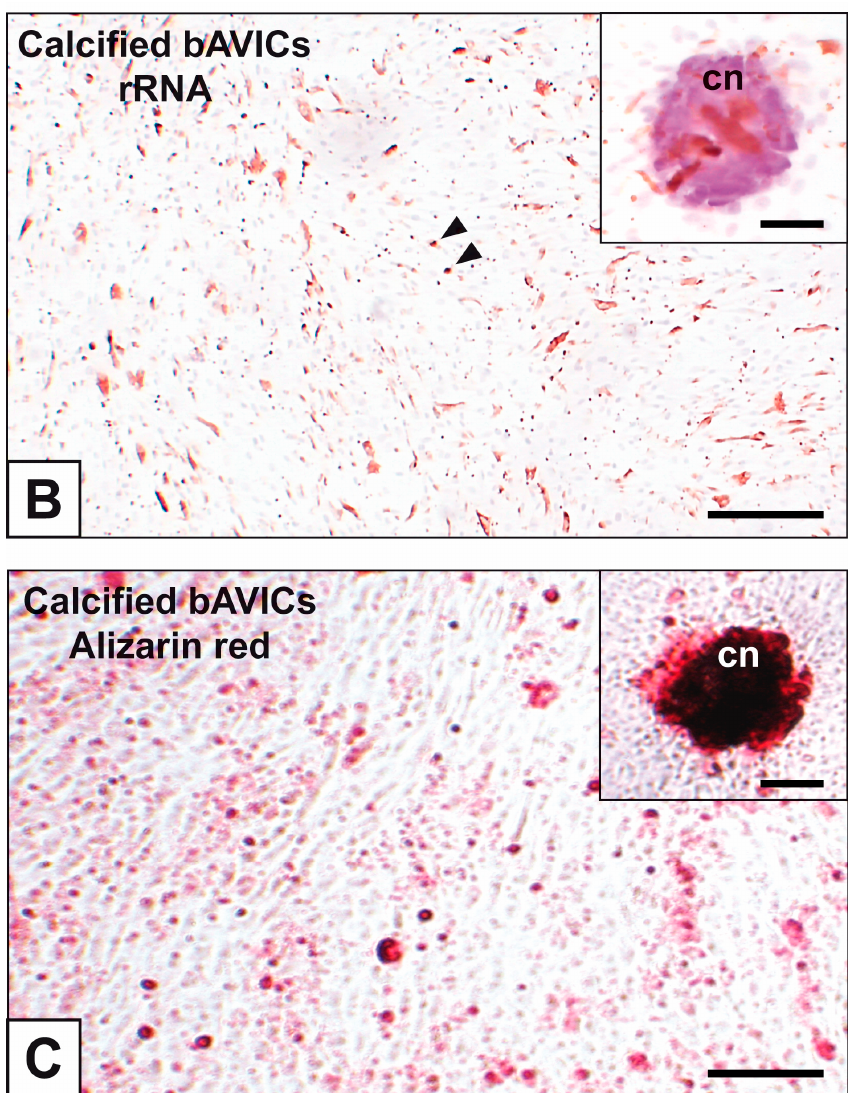
Figure 1. Immunocytochemical detection of rRNA in 15-day-long bovine aortic valve interstitial cell (bAVIC) cultures. ( A ) Immunopositivity of untreated bAVICs. ( B ) Immunopositivity of mineralizing bAVICs as well as vesicular cell debris (arrowheads) and calcific nodule areas (cn; inset). ( C ) Alizarin red calcium staining of mineralizing bAVICs and calcific nodules (cn; inset). Bar: 1 mm.